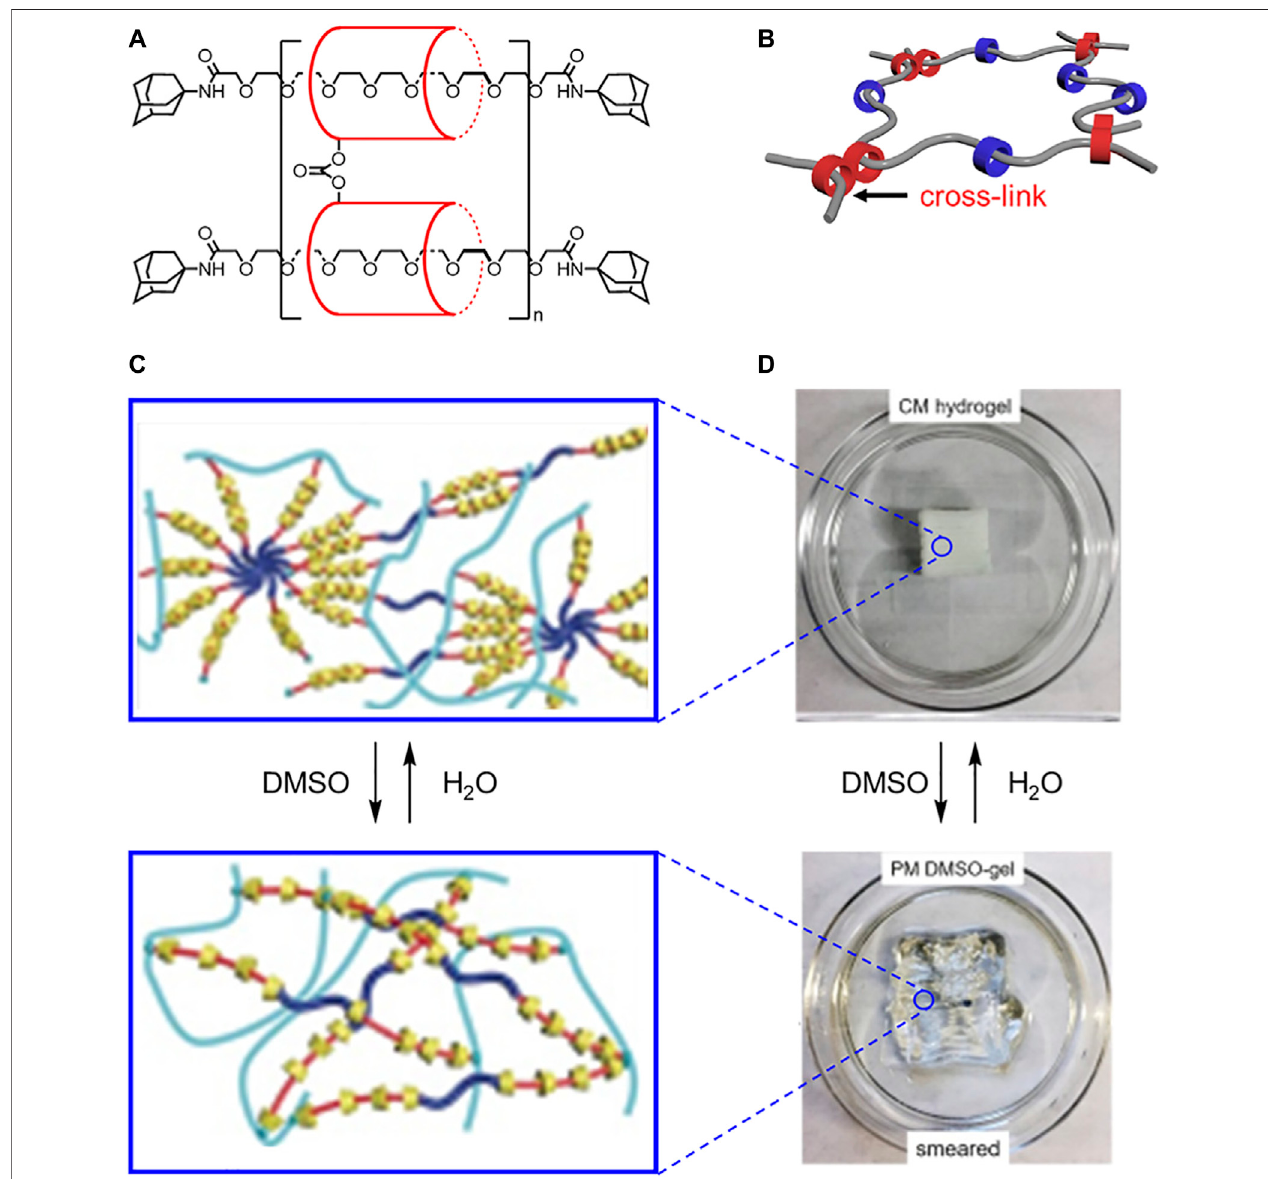
FIGURE 15 | (A) Structure and (B) model of slide ring materials with cross-linked cyclodextrins (red) and free cyclodextrins (blue). (C) Molecular cartoons and (D) 3D printed materials under different solvent conditions. Adapted with permission from Ref. (Lin et al., 2017). Copyright 2017 John Wiley and Sons.